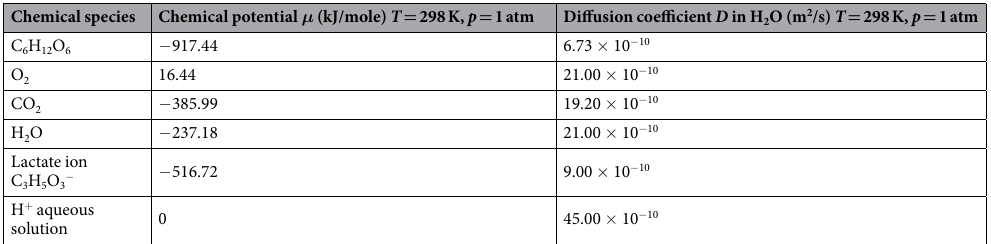
Table 1. Chemical potentials and diffusion coefficients for the chemical species involved in glucose catabolism for cell respiration and lactic acid fermentation. The data are from G. Job and R. Rüffler, Physikalische Chemie, Vieweg + Teubner Verlag Springer